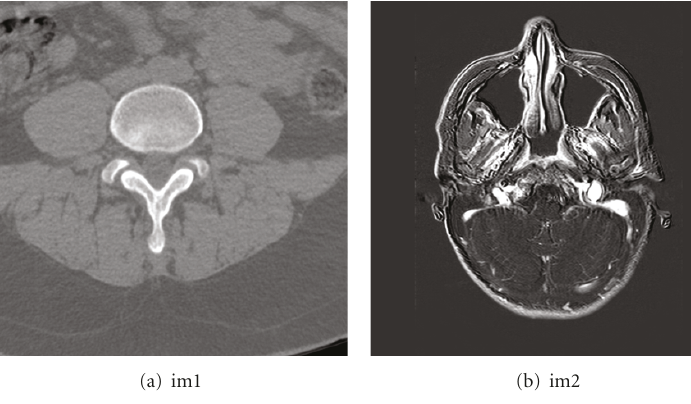
Figure 11: Two medical